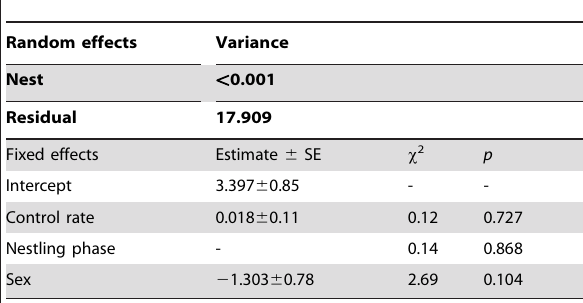
Table 1. Results of a linear mixed effects model investigating the change in provisioning rates of focal birds between the control and playback